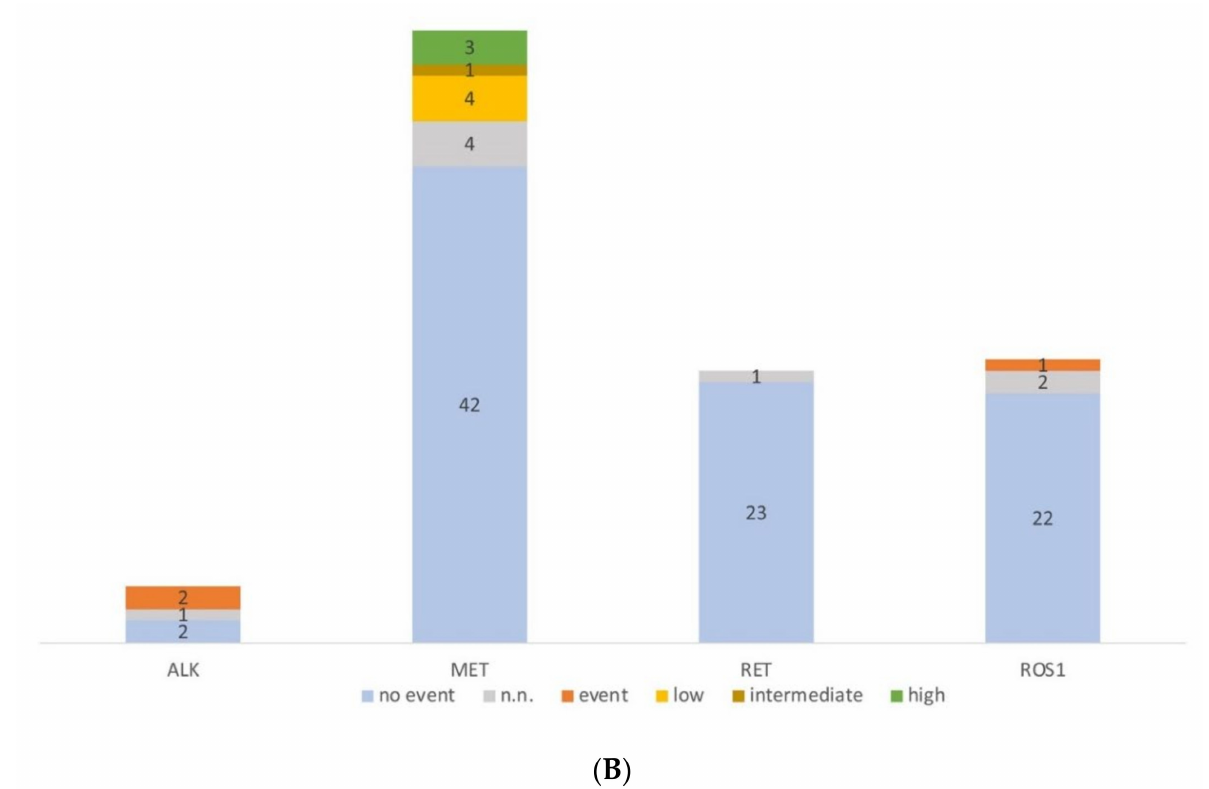
Figure 3. Molecular profiling of serous effusion samples with fast-track analysis, parallel sequencing and fluorescence in situ hybridization from 2018 to 2019. ( A ) Number of mutated and non-mutated samples for fast-track and parallel sequencing analysis. KRAS exon 2 and EGFR exon 19 and 21 within the fast track were analysed with high resolution melting and fragment length analysis. Too low: samples did not have >5 ng DNA/ µ L and were only analysed by parallel sequencing. N.n.: not detectable. In the parallel sequencing, 14/19 genes were analysed, of which the genes BRAF , KRAS , EGFR , ERBB2 , MET , and TP53 were mutated most frequently; only TP53: the sample had no mutation other than a TP53 mutation; TP53 co-mut: the samples had an additional mutation to the TP53 mutation; other: the samples had a mutation outside the before mentioned genes. ( B ) Diagram of the number of fluorescence in situ hybridization on cytological preparations for ALK , RET , and ROS1 translocations and MET amplification. no event: no translocation or amplification, event: translocation or amplification, low/intermediate/high: low/intermediate/high amplification for MET . n.n.: not